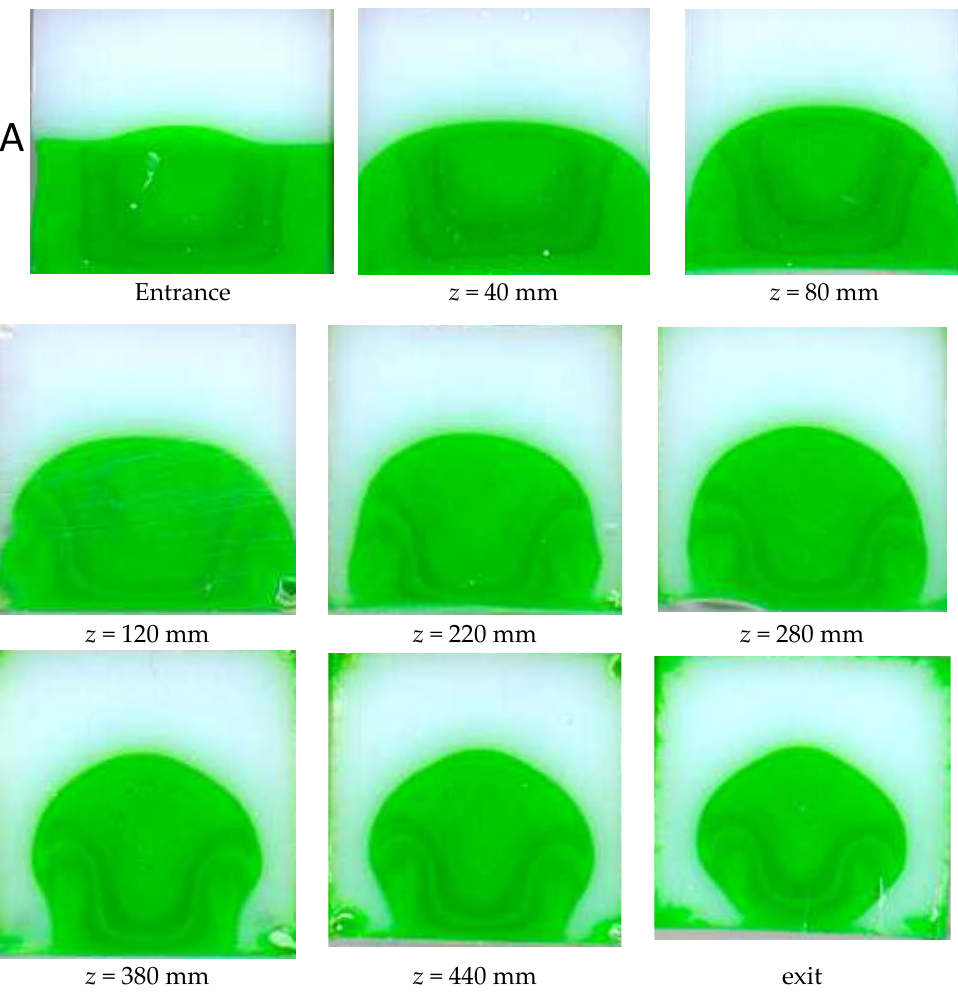
Figure 26. Coextrusion of two polystyrenes (white on the top, green on the bottom) in a long-slit die of square cross-section: successive cuts along the die length (photography reprinted from Ref. [45].